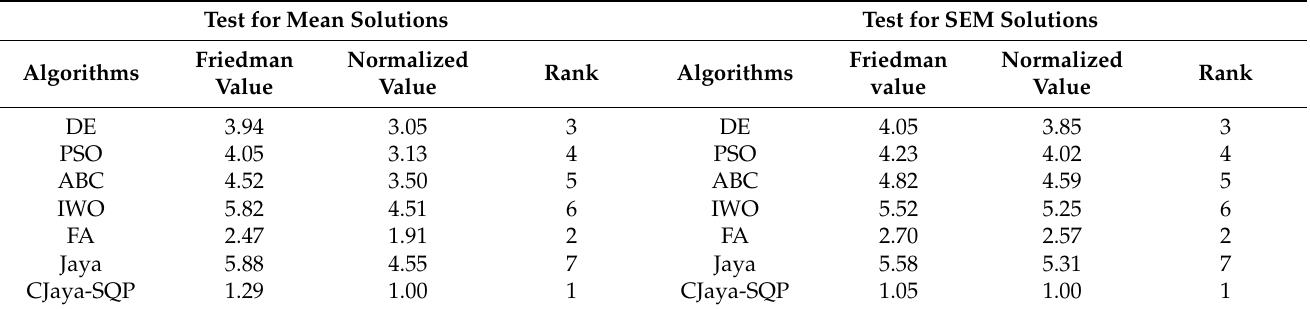
Table 7. Friedman rank test for the ‘Mean’ and ‘SEM’ solutions obtained for 30-dimensional functions over 30